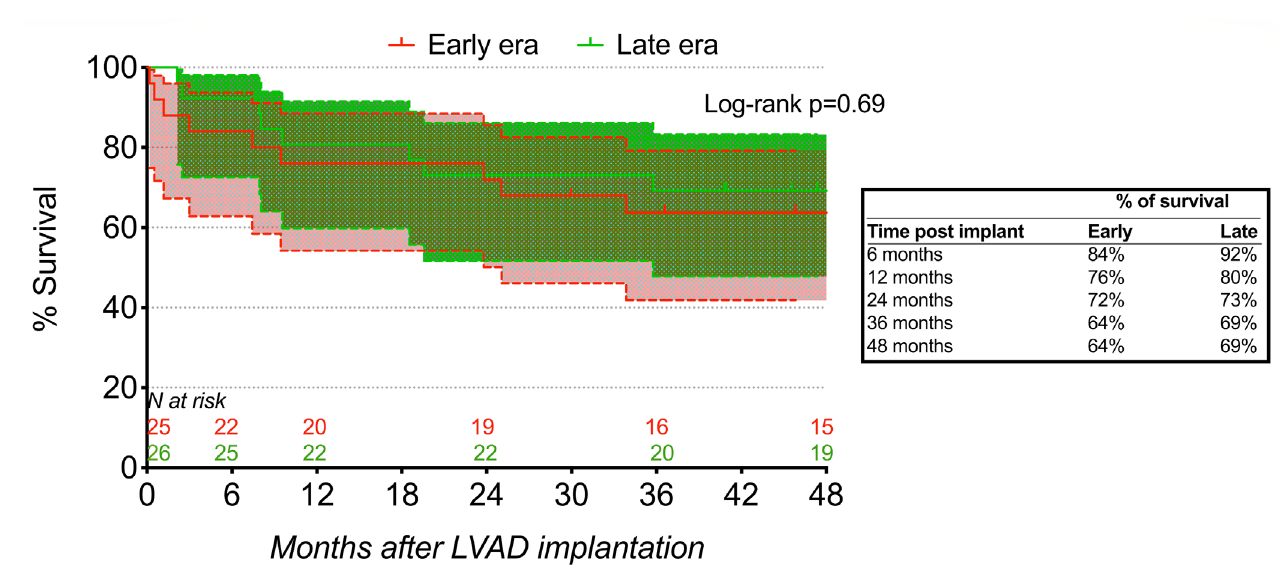
Fig. 2 - Kaplan-Meier survival curves after HeartMate II implantation in the early and late eras.